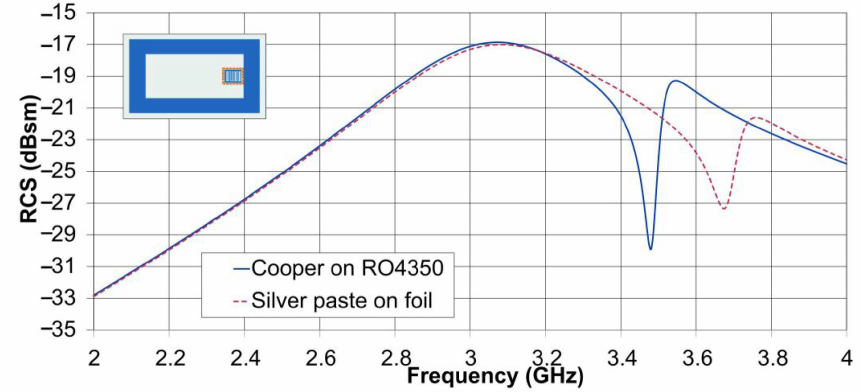
Figure 11. Simulated RCS of IC U-dipole coupled in the metallic loop sensor